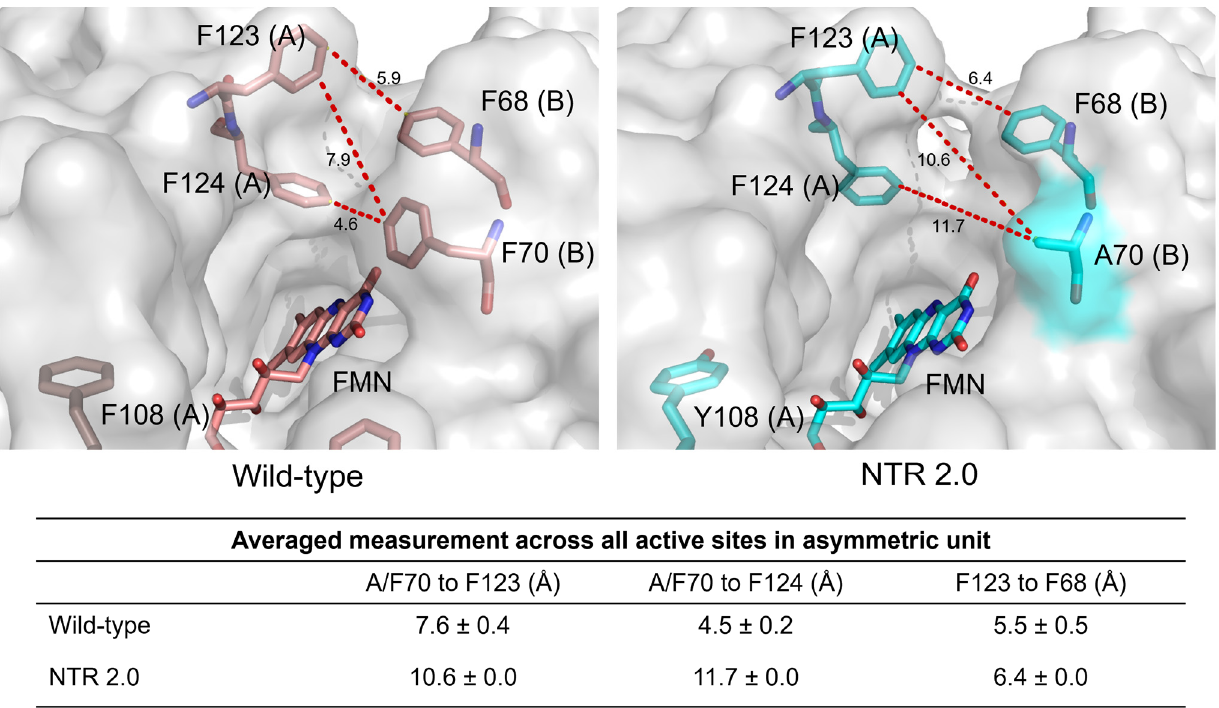
Figure 6. Active site entrance channel width in NTR 2.0 and unmodified V. vulnificus NfsB. Residues at positions 68, 70, 108, 123 and 124 and FMN are shown as sticks and measurements are in Å. Distances between residues 123 and 70, 124 and 70, and 123 and 68 were measured in PyMOL for each active site in the asymmetric unit of each structure and the average measurement ± SD was calculated. In each structure, measurement was taken from the F124 atom closest to F70. Chain identity (A or B) is identified in parentheses after each numbered residue.